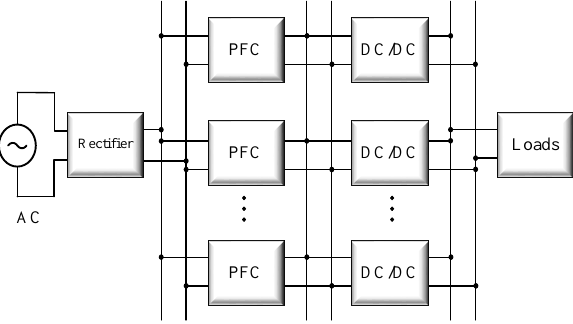
Figure 1. Schematic diagram of distributed power system.